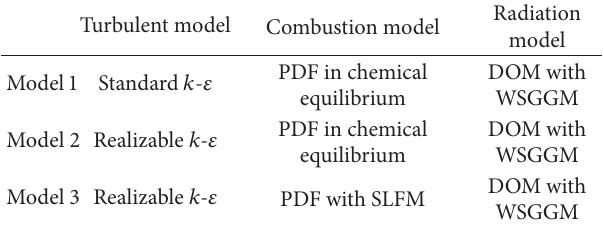
Table 1: The detail of the three developed CFD models.